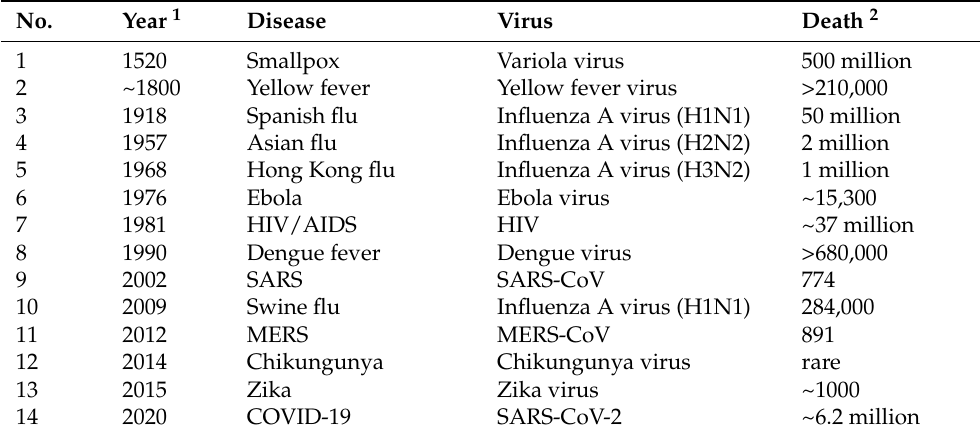
Table 1. The global epidemic and pandemic of viral diseases throughout